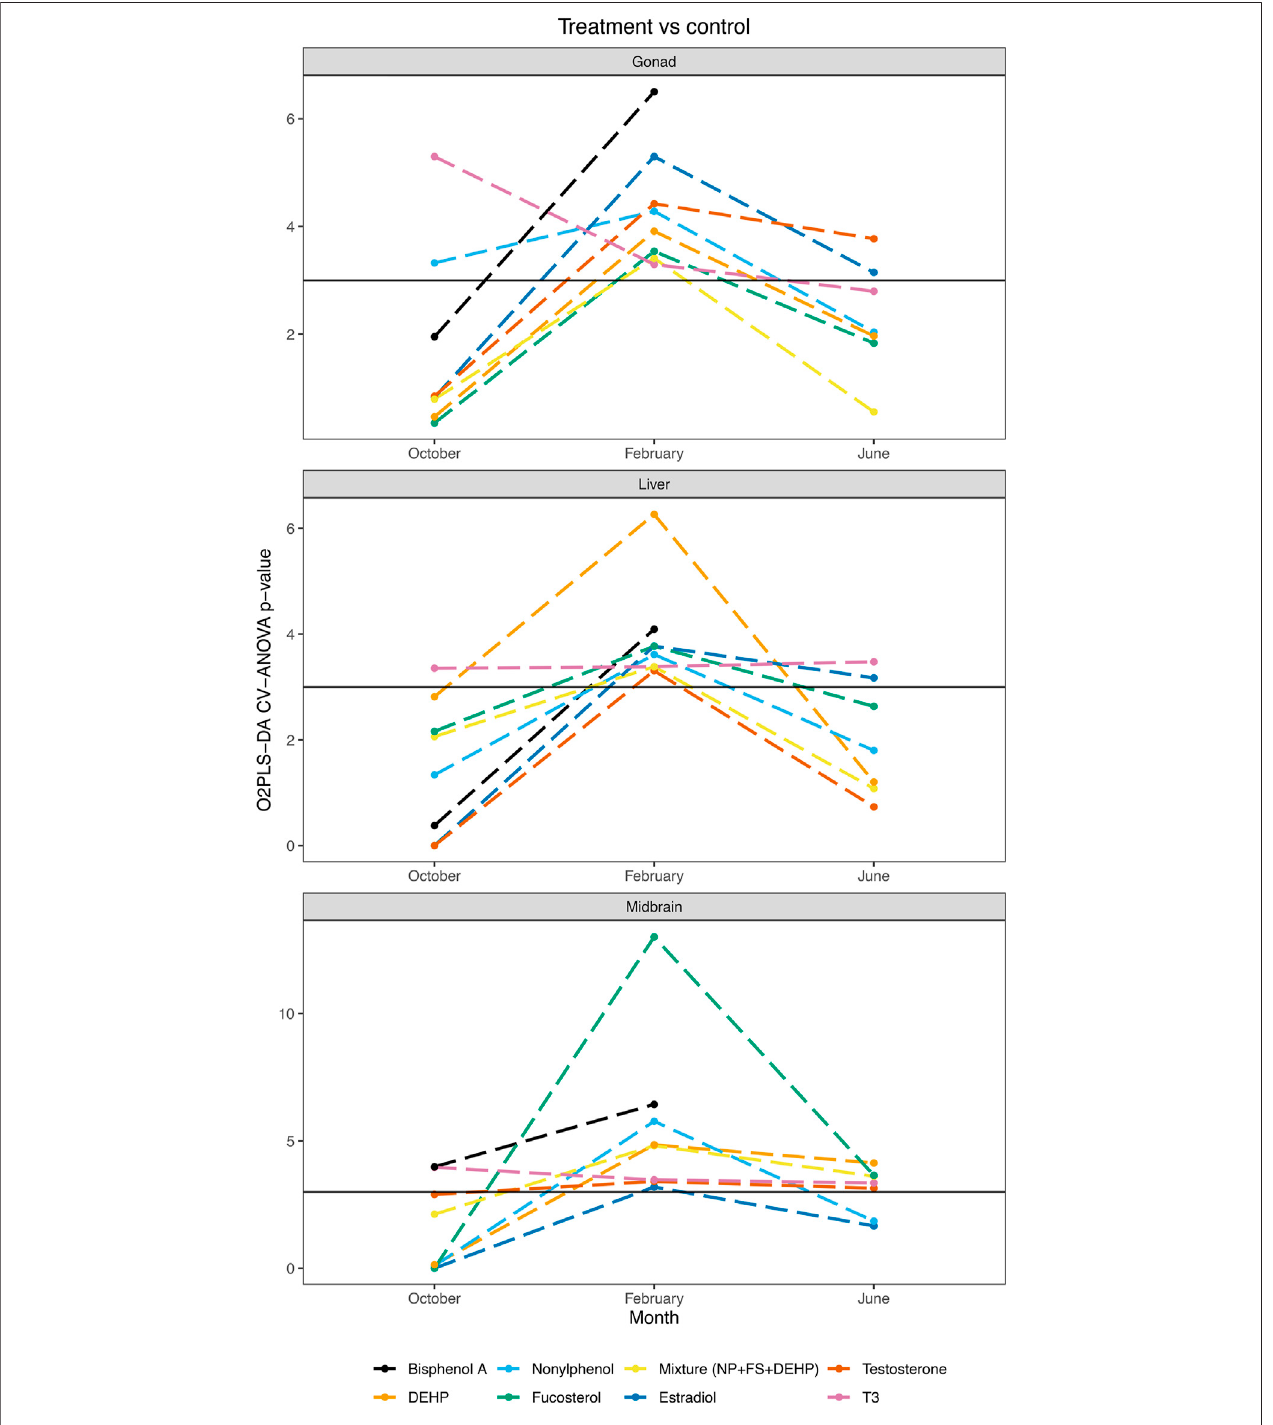
FIGURE3| O2PLS-DAcontrolvstreatmentpairwisemodelingsummaryacrosstissuesandseasons.SummaryofO2PLS-DApairwisemodelingresultsassessing control vs individual treatment pairs in midbrain, gonad and liver in October, February and June. CV-ANOVA p -values are plotted on a logarithmic scale.